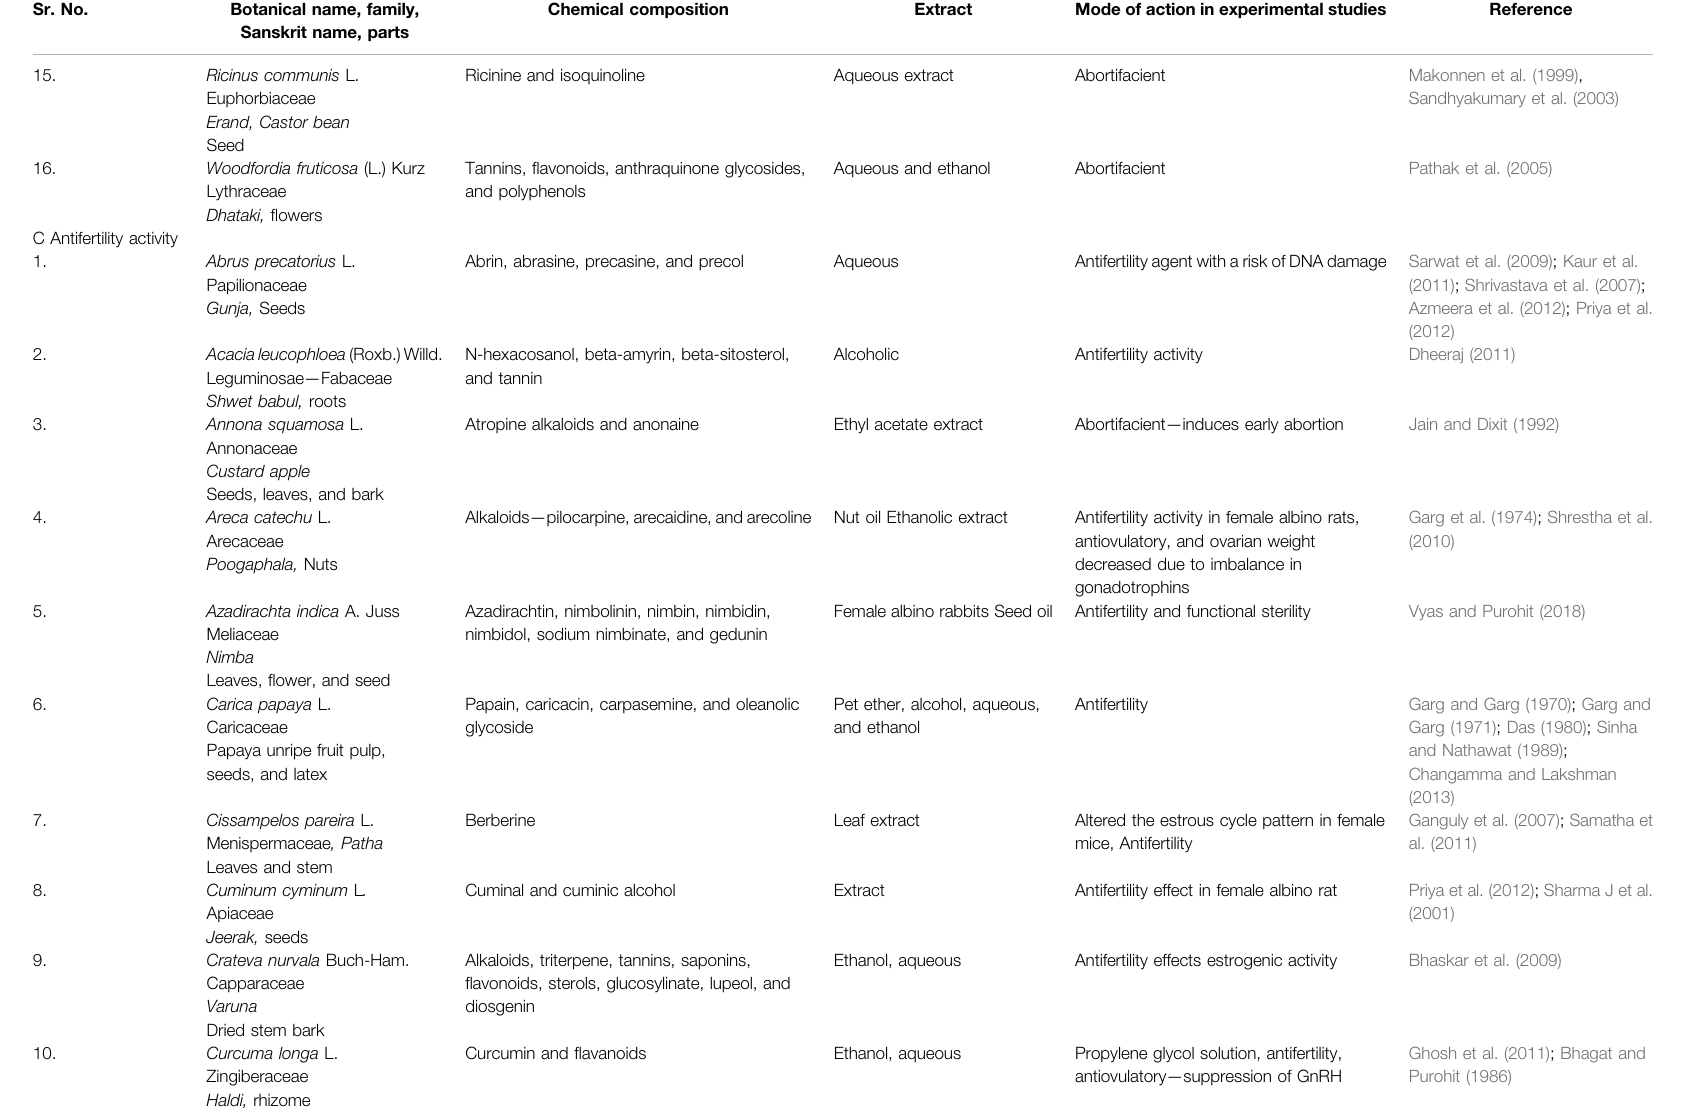
TABLE 2 | ( Continued ) Medicinal plants and their phyotoconstituents validated for various female/male contraceptive activities. Different contraceptive activities studied on medicinal plants could be categorized as follows. Female contraceptive activities: (2A) anti-implantation activity, (2B) aborti fi cation, (2C) antifertility, (2D) antiovulatory, and (2E) antiestrogenic activity. Male contraceptive activities: (2F) antispermatogenic, (2G) spermicidal, and (2H) antiandrogenic